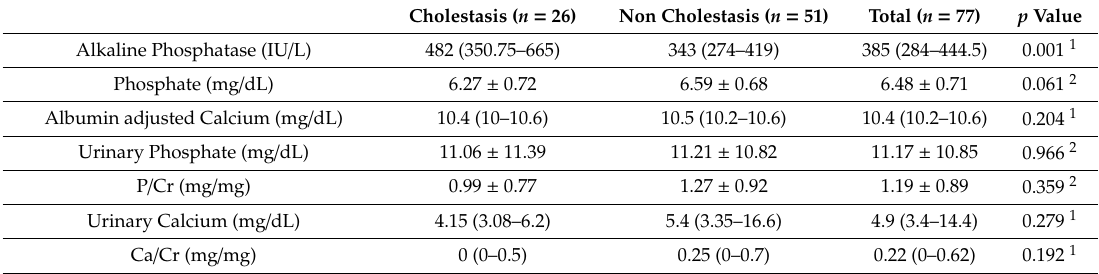
Table 1. Biochemical determinations from preterm infants in the Retrospective Group (RG). Comparison of the di ff erent biochemical values according to cholestasis and non-cholestasis criteria.